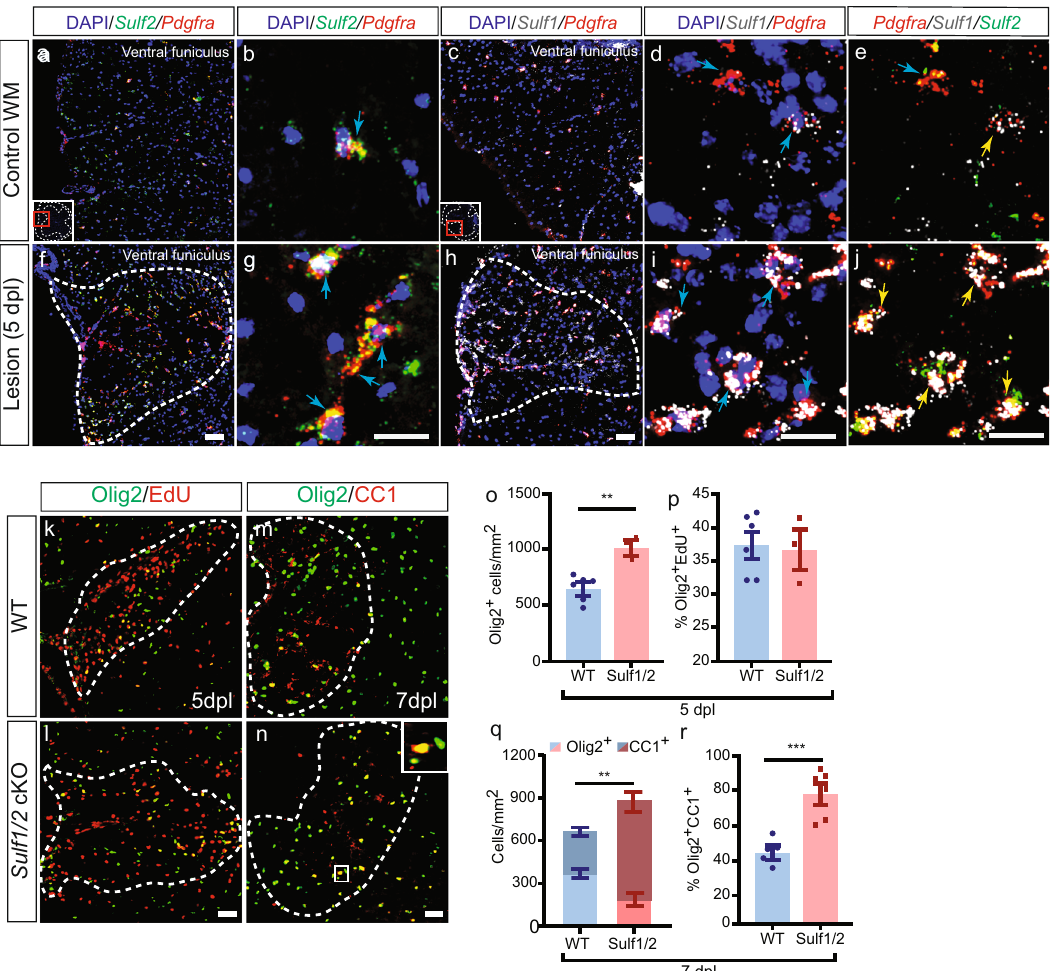
Fig. 2 Conditional genetic ablation of OPC-expressed Sulf1/2 accelerates oligodendrocyte recruitment and lesion colonization following demyelination. a – j Dual RNAscope in situ hybridization (ISH) of mouse spinal cord ( a – e ) revealed increased Sulf1 and Sulf2 mRNA expression following lysolecithin- induced demyelination ( f – j ; 5 d.p.l.). Sulf1 (gray), Sulf2 (green), or Pdgfra mRNA (red) and DAPI (blue). Yellow arrows denote Pdgfra + OPCs that co- expresses Sulf1/2 . Blue arrows denote Sulf2 + Pdgfra + OPCs or Sulf1 + Pdgfra + OPCs. RNAscope images were imaged by confocal microscopy, others using wide fi eld epi fl uorescence. Inducible NG2creER-mediated OPC-speci fi c ablation of Sulf1 / 2 ( Sulf1/2 cKO) in adult mice followed by lysolecithin-induced demyelination ( k – r ). Analysis of OPC dynamics at 5 days post lesion (d.p.l.) ( o – p ) ( n = 6 and 3 mice, for WT and Sulf1/2 cKO respectively) and 7 d.p.l. ( q – r ) ( n = 5 and 6 mice, for WT and Sulf1/2 cKO, respectively). At 5 d.p.l., Olig2 + cell density was signi fi cantly increased in Sulf1/2 cKO ( o ) (** p = 0.0016, two-sided t test). No difference in the proportion of proliferating EdU + Olig2 + cells compared to wild type ( p ). At 7 d.p.l., Sulf1/2 cKO exhibited increased overall Olig2 + and postmitotic Olig2 + CC1 + oligodendrocyte density ( m , n ) (cells/mm 2 quanti fi ed in q , ** p = 0.0027 and 0.00071, two-sided t test). The percentage of CC1 + Olig2 + oligodendrocytes among Olig2 + cells was increased in Sulf1/2 cKO animals compared to controls ( r , *** p = 0.0009, two-sided t test). Mean ± SEM shown. Scale: 20 µ m ( a , f , c , h ), 40 µ m ( b , g , d – j ), and 10 µ m ( k – n